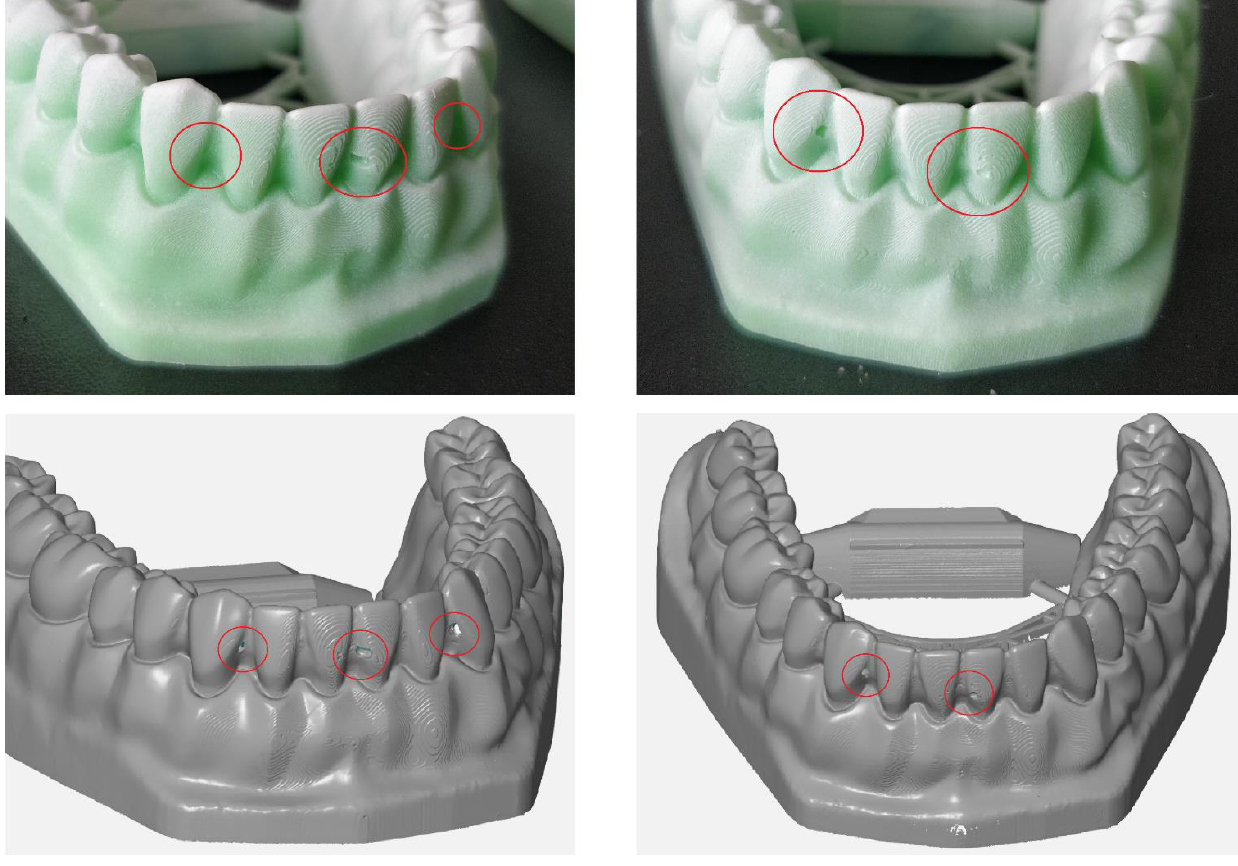
Figure 7. Defects, shown in red circles, in two models printed with the material from Producer 3 visible in the resulting